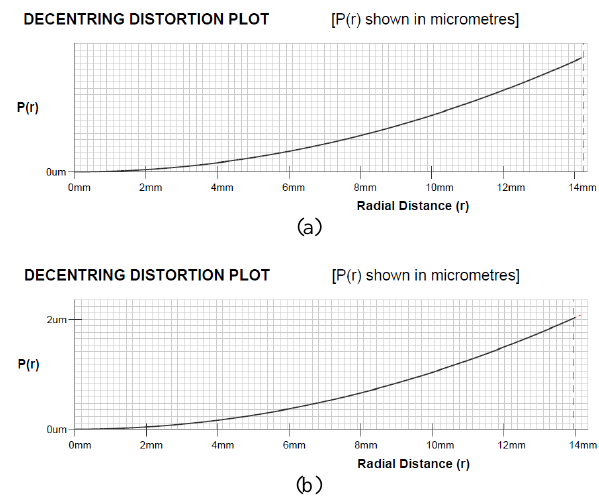
Figure 8. Decentring distortion plots showing distortion (Y- axis, µm), against radial distance (X-axis, mm) for results of camera calibration obtained from (a) Cage and (b) Box. The plots are obtained from Australis software Fig. 8a and Fig.8b show the results for decentring distortion obtained using the cage and the box, respectively. The results for the Puget Sound camera are shown in Table 3. In this case, the smaller box was used, because it had a very small field of view. Almost 135 images were used to arrive at the